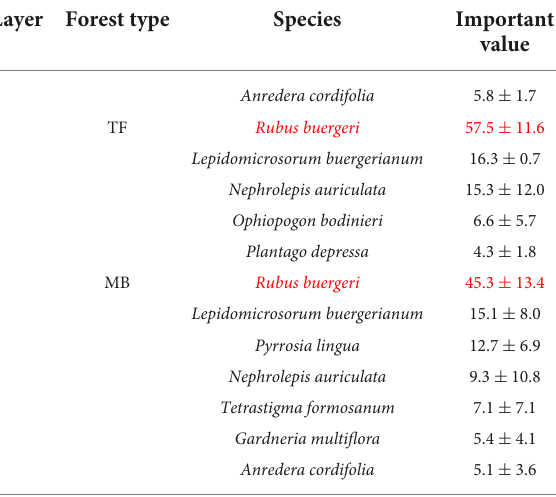
TABLE 3 Effects of Moso bamboo invasion on main species composition and importance value (mean ±